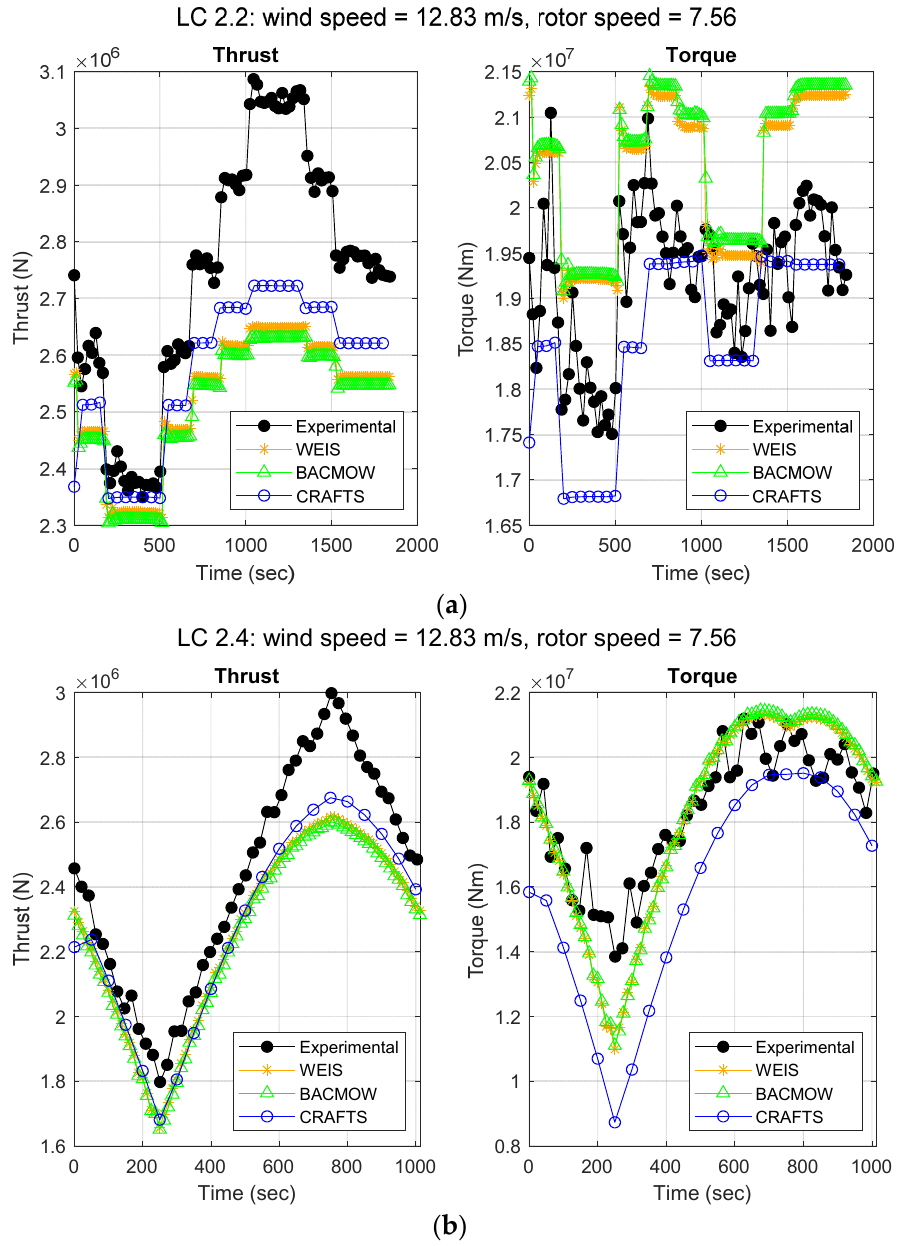
Figure 7. Thrust and torque histories for ( a ) LC 2.2 and ( b ) LC 2.4.